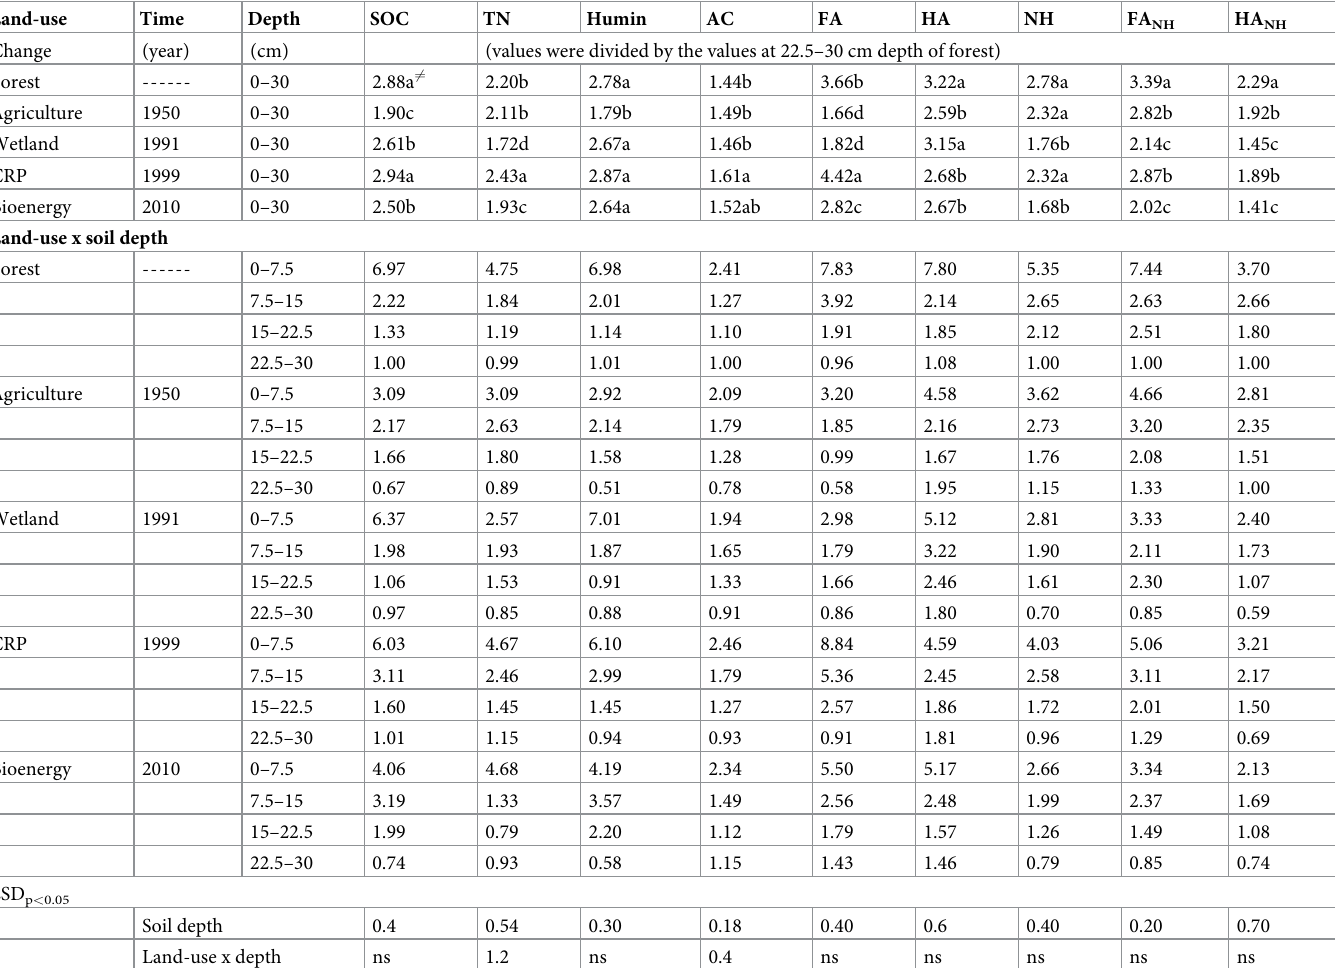
Table 5. Impact of deforestation and subsequent land-use diversity on the stratification of total organic carbon (SOC), total nitrogen (TN), active carbon (AC), ful- vic acid (FA), humic acid (HA), humin, and glucose equivalent total non-humic carbon (NH), fluvic acid associated glucose equivalent total non-humic carbon (FA NH ), and humic acid glucose equivalent total non-humic carbon (HA NH ) pools at different soil depths. Land-use (values were divided by the values at 22.5–30 cm depth of forest)